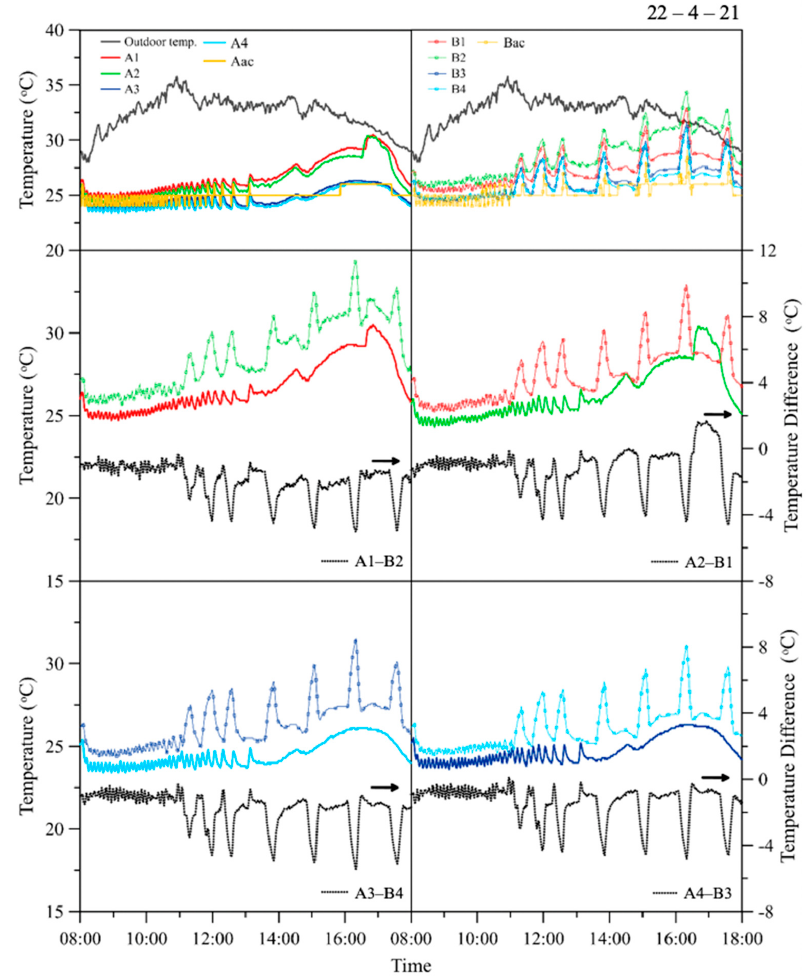
Figure 7. Temperature and temperature differences of rooms A and B (day